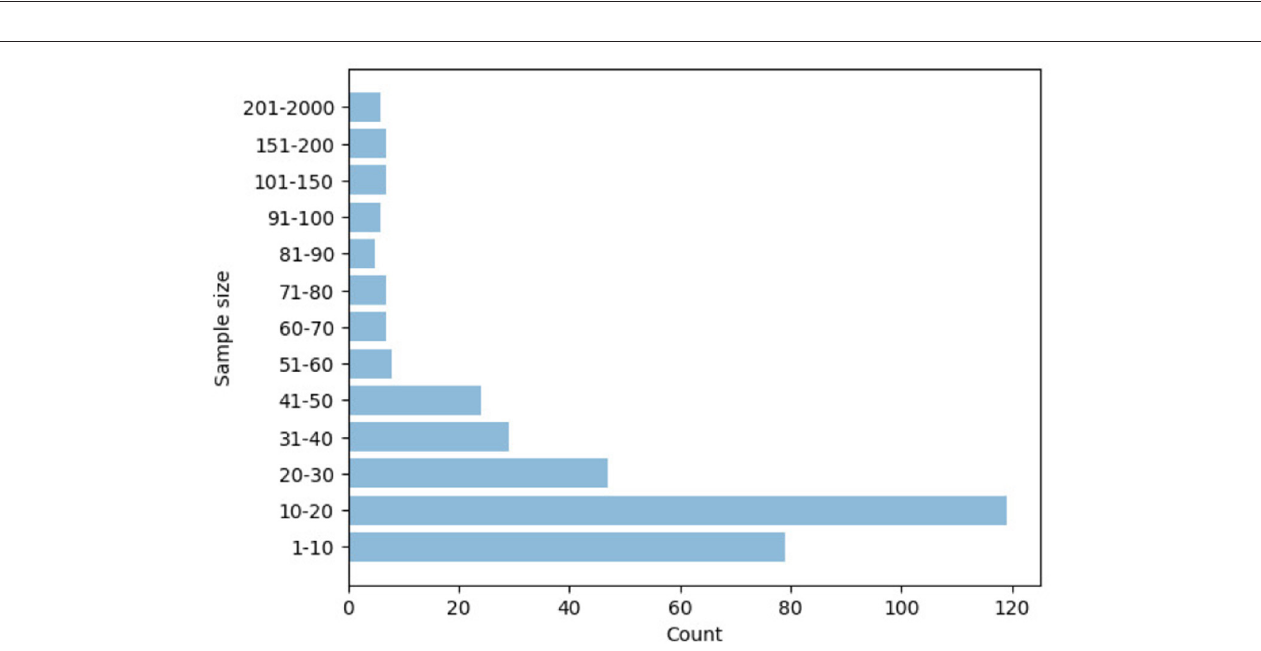
FIGURE 7 | Distribution of the articles by sample size of